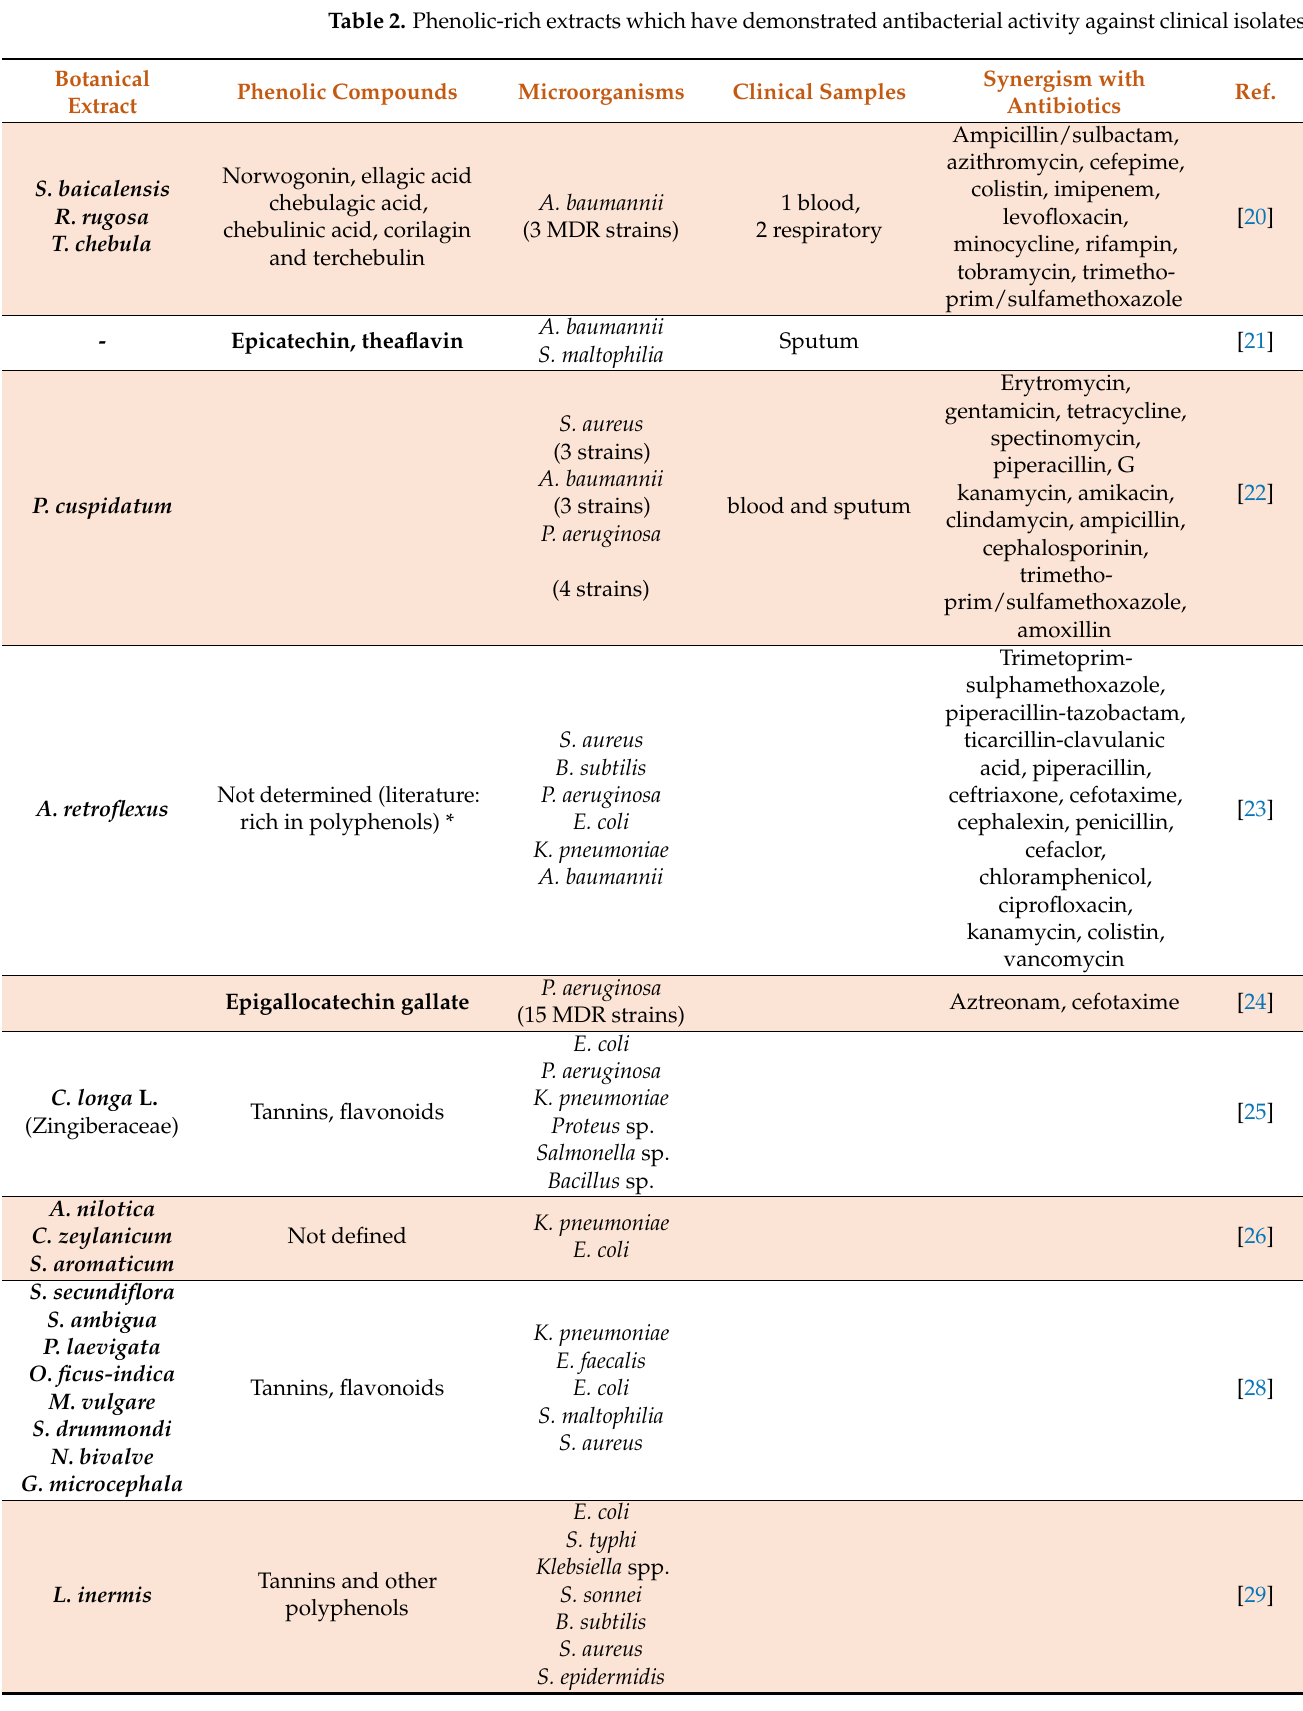
Table 2. Phenolic-rich extracts which have demonstrated antibacterial activity against clinical isolates. Microorganisms Clinical Samples